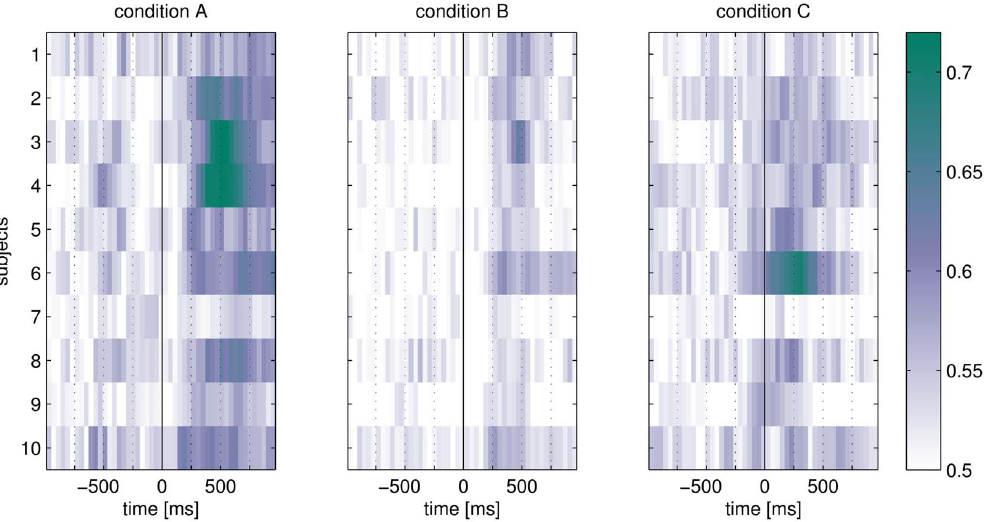
Figure 7. Comparison of class-discriminative information contained in the time structure of one epoch. For each subject and condition, one row depicts the estimated sliding binary classification accuracy (SBCA) of a window of 60 ms width. It was estimated by cross-validation with a 0.5 chance-level.